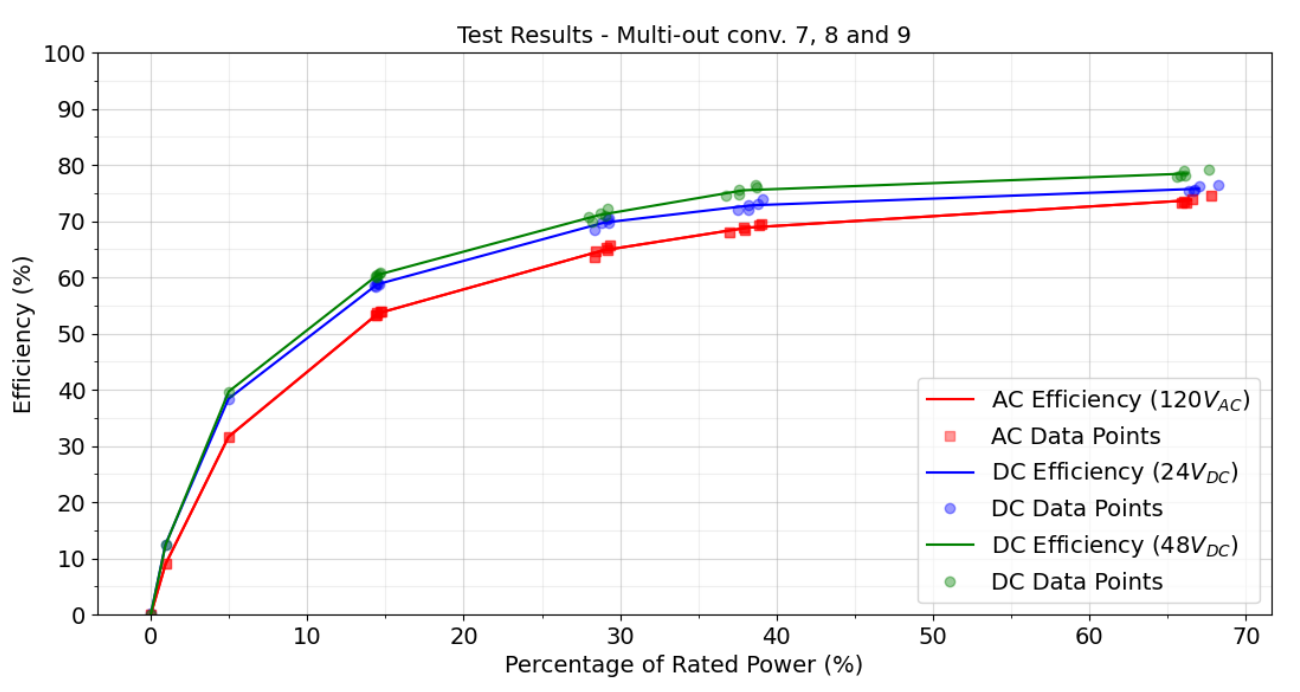
Figure 4. AC and DC efficiency comparisons for 70 W SIMO power supplies for the test plan in Table 5. Converter 7 is the AC/DC converter (red line); the blue line shows converter 8, a DC/DC converter with 24 V DC input; and the green line is converter 9 with a 48 V DC